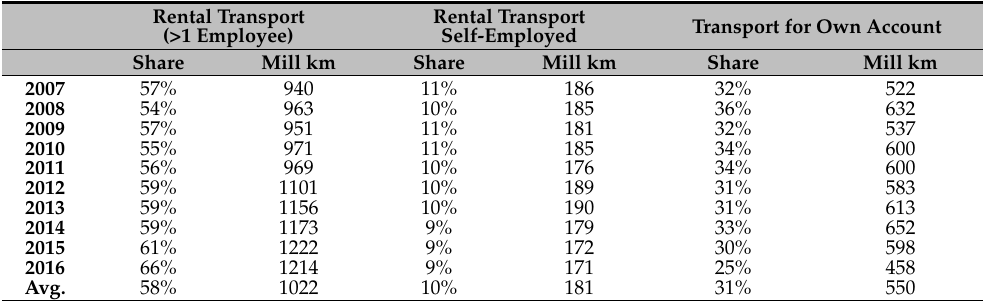
Table 2. The development in kilometres driven by self-employed and employed drivers, measured as million kilometres, and shares. The focus is national transport. (Avg. = average).